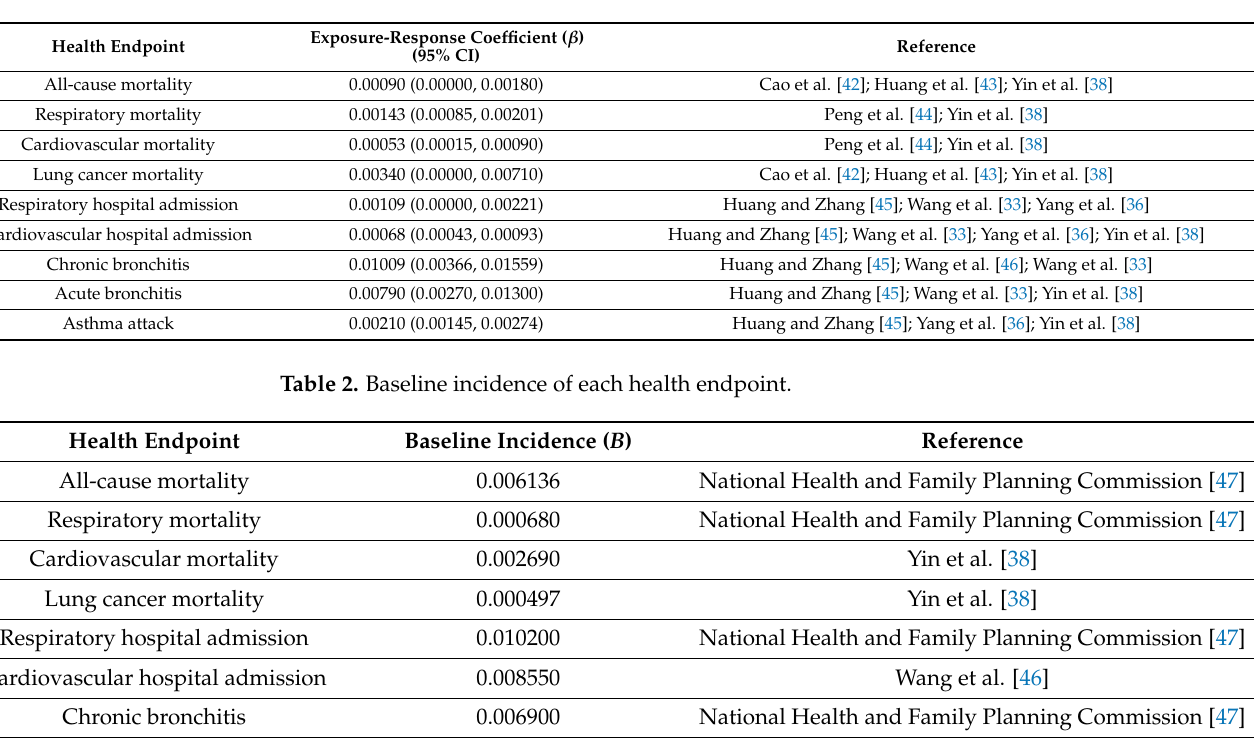
Table 1. PM 2.5 exposure-response coefficient of each health endpoint.